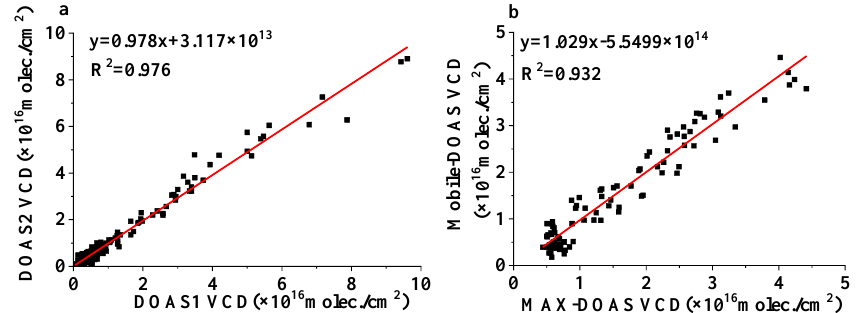
Figure 5. Retrieval comparison results. ( a ) The retrieval homogeneity of the 2 mobile-DOAS instruments with a correlation coe ffi cient (R 2 ) of 0.976; ( b ) the comparison result for mobile-DOAS (DOAS1) and MAX-DOAS with a correlation coe ffi cient (R 2 ) of 0.932.